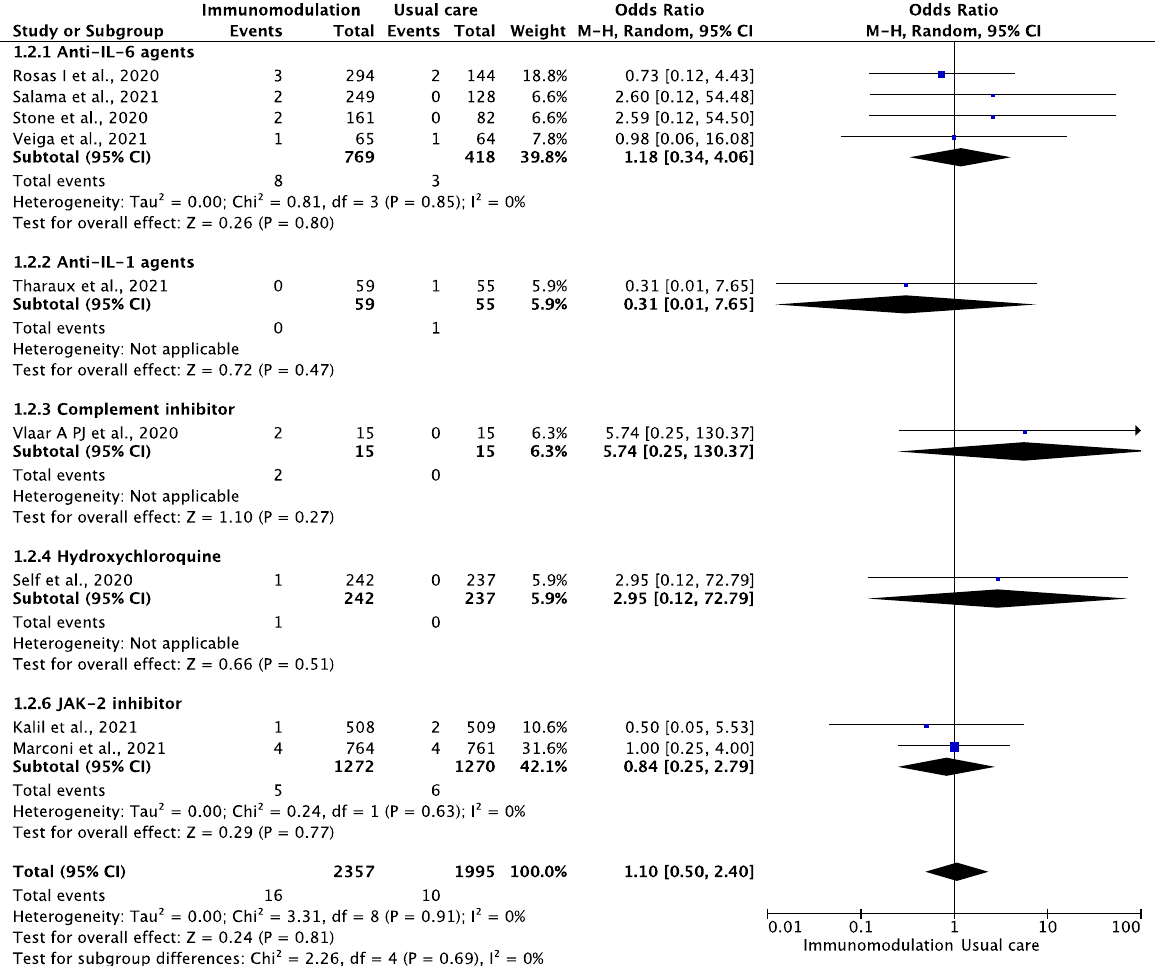
Figure 3. Odds ratio (OR) and 95% confidence intervals for the occurrence of myocardial infarction among the hospitalized COVID-19 patients prescribed immunomodulatory agents as an add-on to SOC vs. SOC only. Boxes represent the OR and lines represent the 95% CIs for individual studies. The diamonds and their width represent the pooled ORs and the 95% CIs, respectively. CI, confidence interval for the Mantel–Hansen estimator, I 2 : heterogeneity.